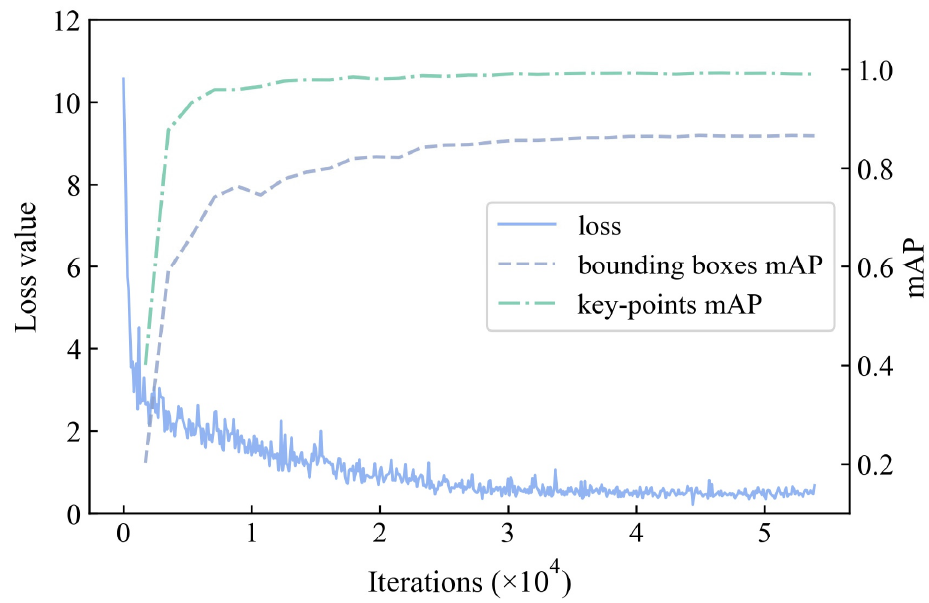
Figure 5. Training process of ResNeXt with I-PANet.